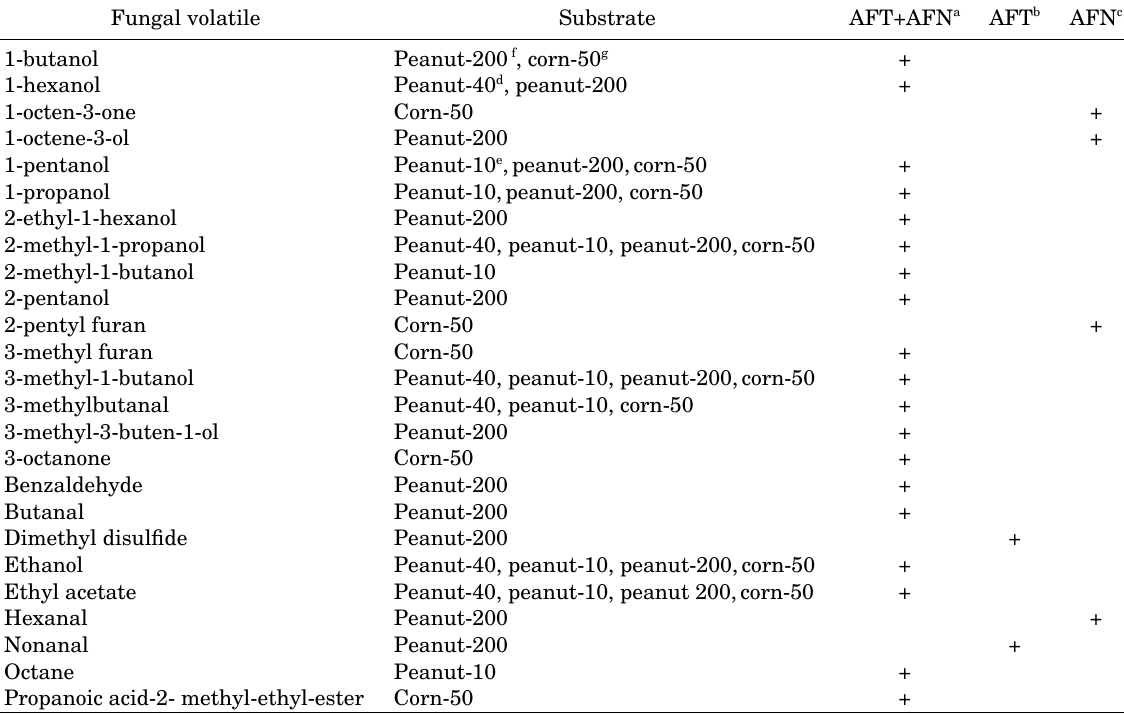
Table 1. MVOCs in headspace gases associated with Aspergillus fl avus a fl atoxigenic (AFT) and non-a fl atoxigenic (AFN) strain growth on peanut and corn substrate with continuous or discontinuous air fl ow.